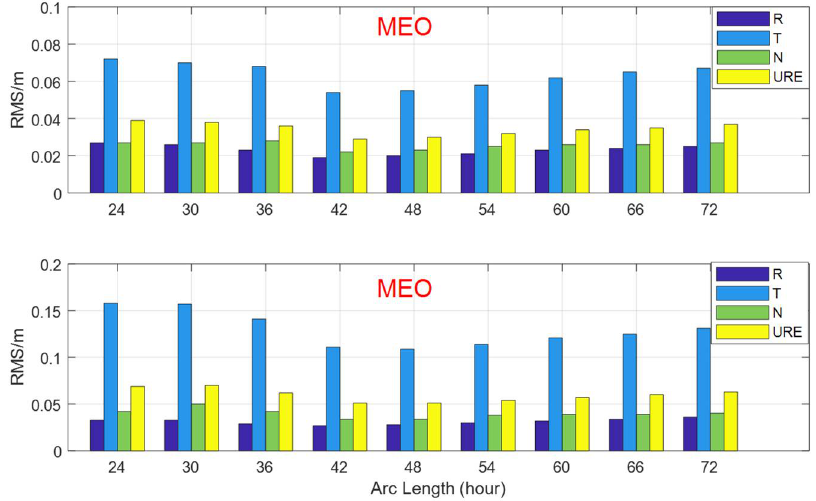
Figure 1. The accuracy of the first 6 h ( top ) and 24 h ( bottom ) of predicted BDS-3 MEO orbits with different arc lengths.